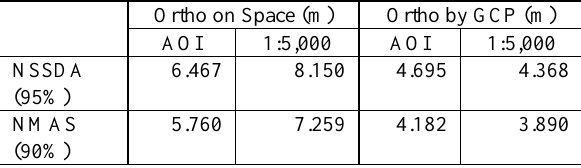
Table 6. Planimetric accuracy of SPOT6 data